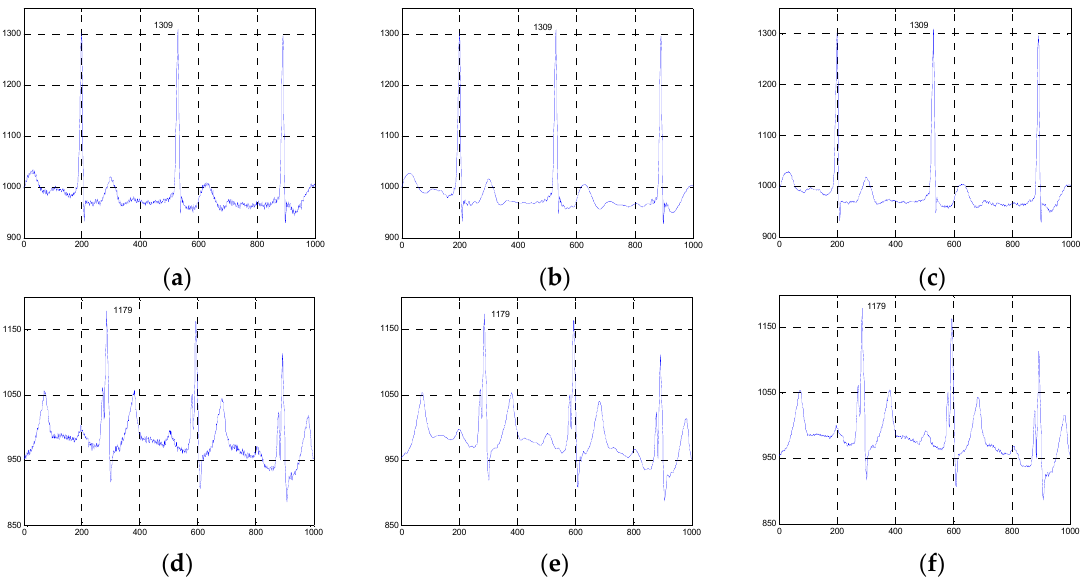
Figure 13. Comparison of the denoised results for the ESMD-NLM and NLM methods operating on the 111m.dat and 221m.dat in the first group of clinical ECG signals. ( a ) The clinical ECG signal (111m.dat), ( b ) the ESMD-NLM method (111m.dat), ( c ) the NLM method (111m.dat), ( d ) the clinical ECG signal (221m.dat), ( e ) the ESMD-NLM method (221m.dat), ( f ) the NLM method (221m.dat).